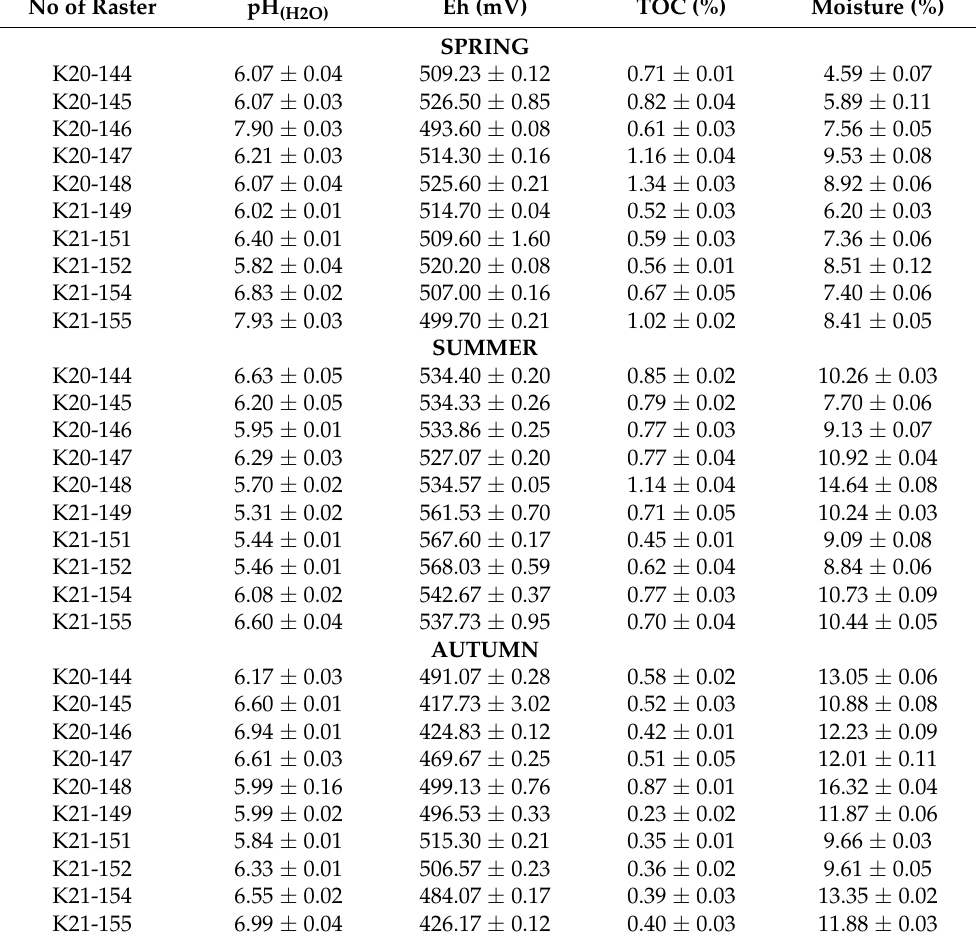
Table 1. Basic chemical properties of the fields in different seasons: K20-intercropping mixture and K21-maize monoculture (mean values of three replicates ± standard deviation